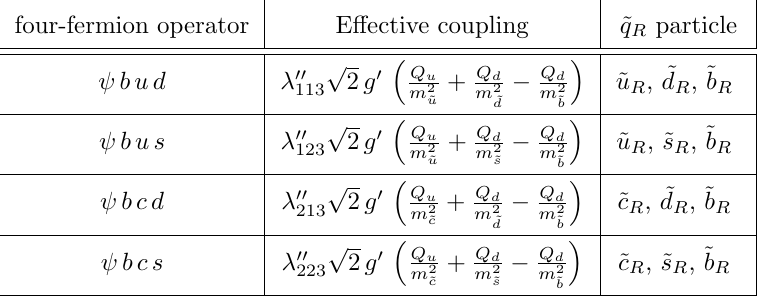
Table 3. Exhaustive list of all the possible operators contribution to the baryogenesis mechanism in a U(1) R supersymmetric setup with Dirac